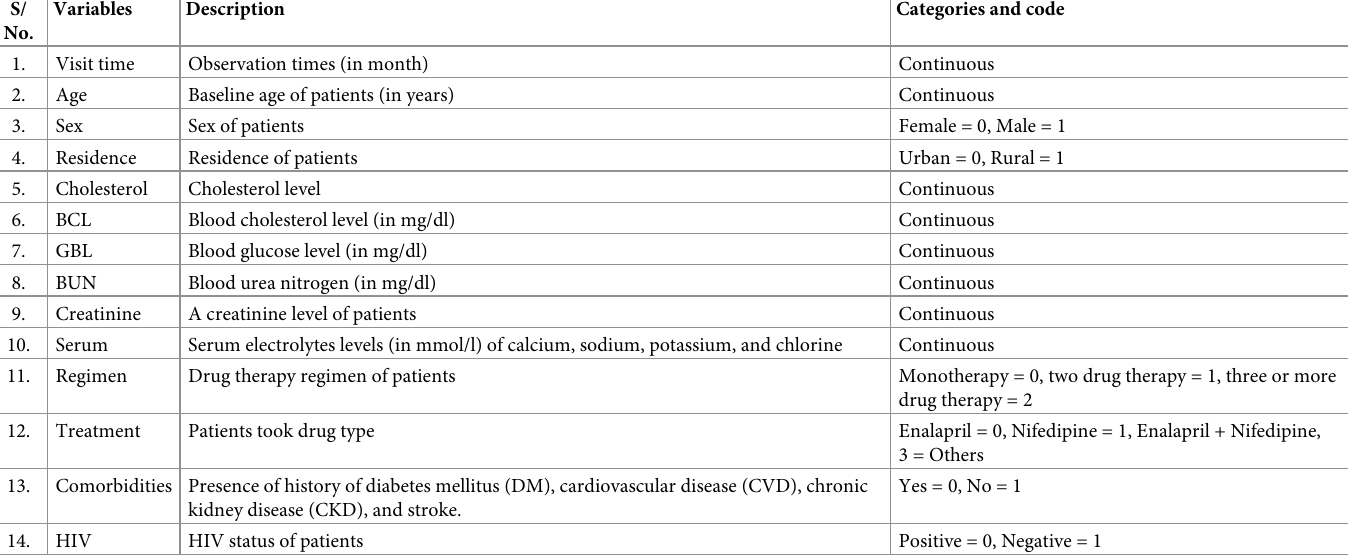
Table 1. Independent variables and